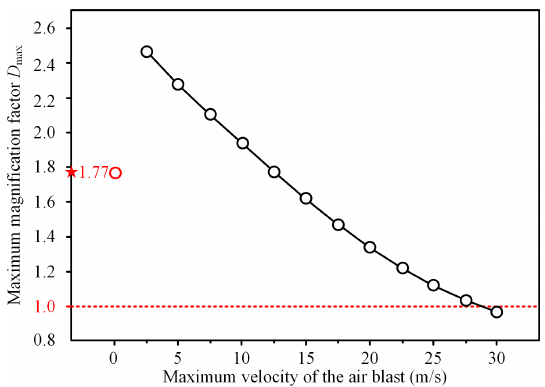
Figure 7. Impact of large tree deflection on the maximum magni- fication factor D max . The red star represents the D max calculated from Eq. (18). The red circle represents the D max corresponding to the scenario with a very low air blast velocity (maximum velocity of 0.1ms − 1 ), and the eccentric gravity is not